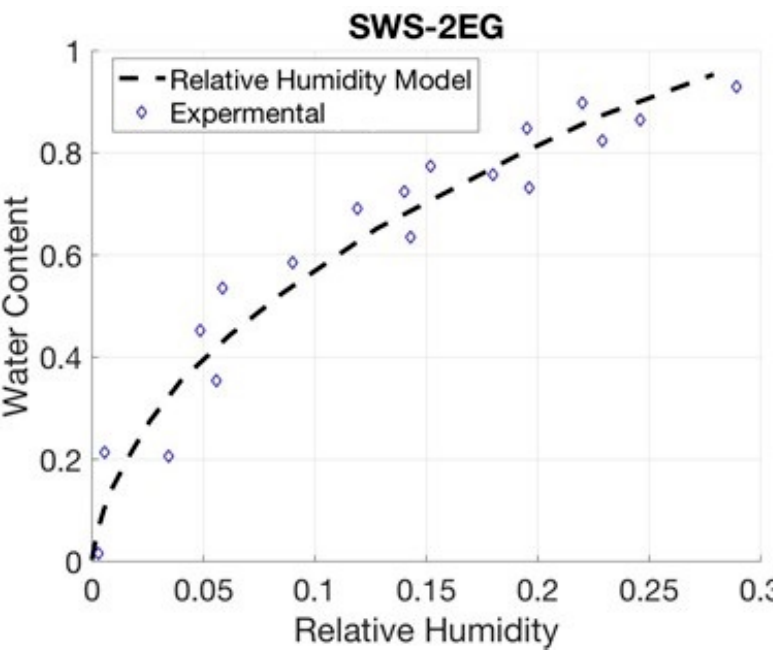
Figure 9. Comparison of relative humidity model of SWS-2EG nanoparticles [28].